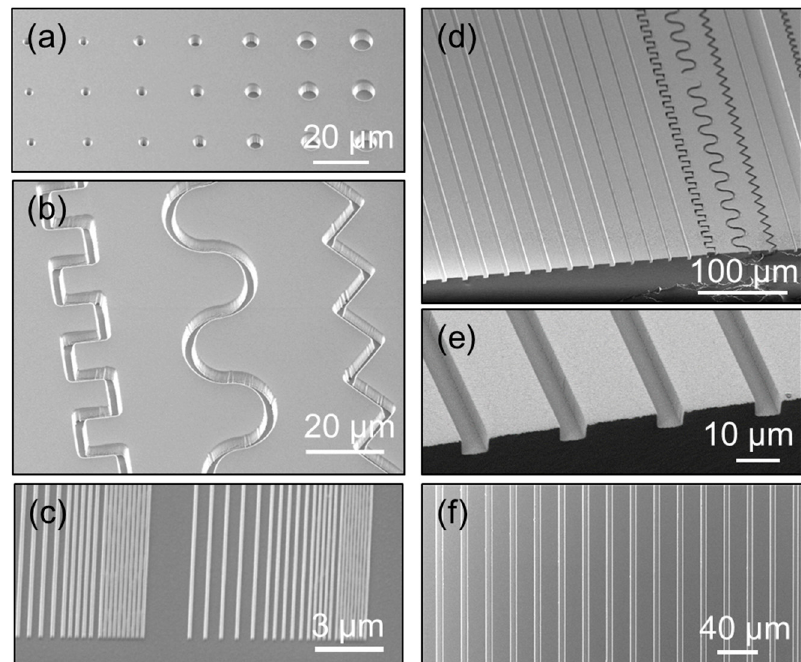
Figure 6. SEM images of micro- and nano-imprinted structures are shown. The structures vary from dots, lines, meander structures, and rely only on the quality of the structures in the stamp. Micro structures with different shapes and configurations are shown in ( a , b , d , e,f ) (dots, meandering lines, straight lines). And also lines with nanometric dimensions, down to 75 nm wide, as shown in ( c ).